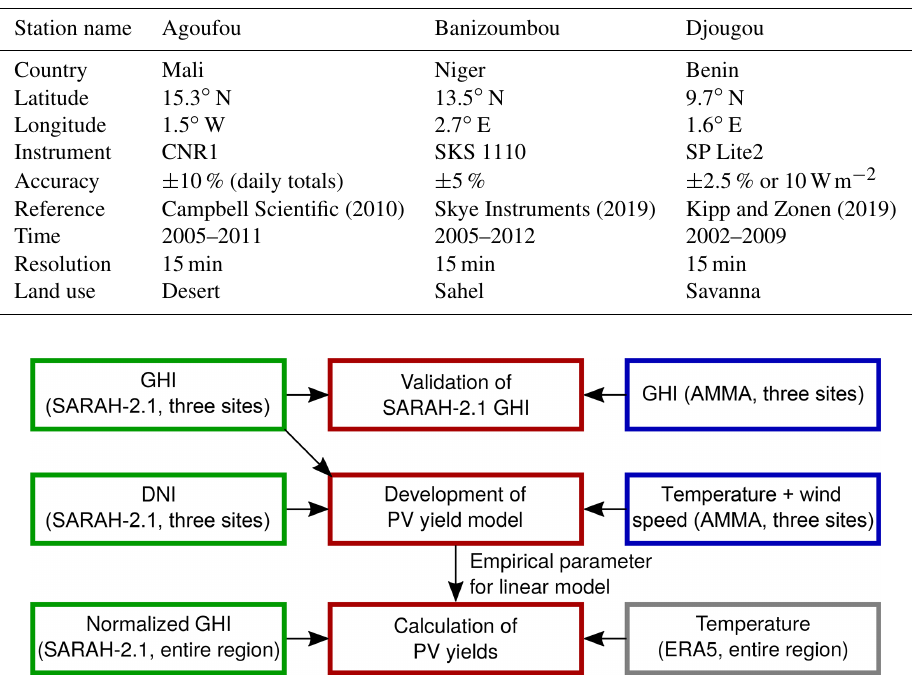
Figure 2. Connection of calculation steps (red) within this study, including all of the input data required (green denotes satellite data, gray denotes reanalysis data and blue denotes observational